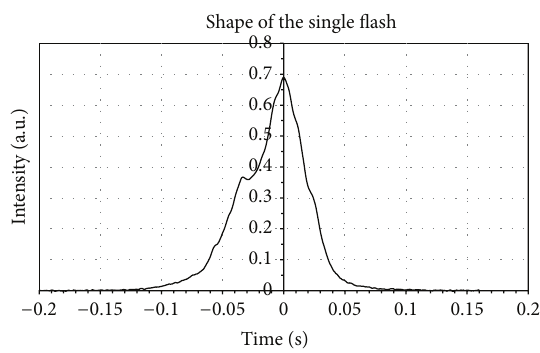
Figure 8: Average time trend (“form”) of each flash intensity. next section. For this reason some photometric measure- ments were executed from the ground with the purpose of quantifying the optical characteristics of the lighthouse